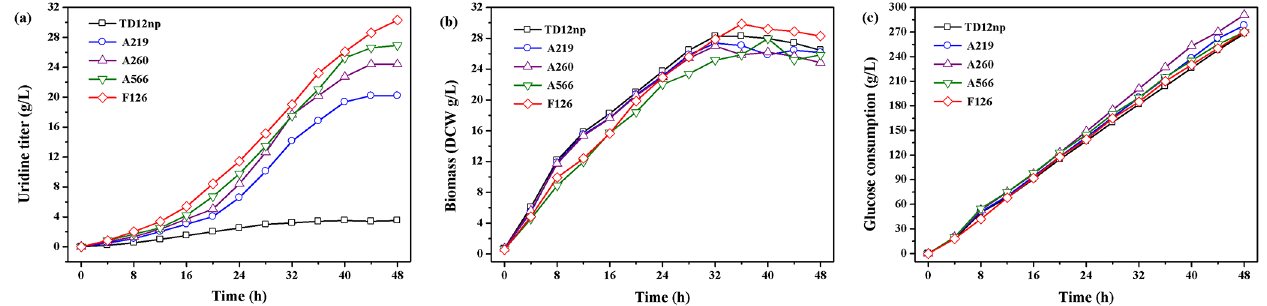
Fig 5. Time course of uridine production by mutant A219, A260, A566, F126 and parent strain TD12np in 48 h fed-batch fermentation. (a) Uridinetiter; (b) Biomass; (c) Glucose consumption.Each plot representsthe averageof three samples.